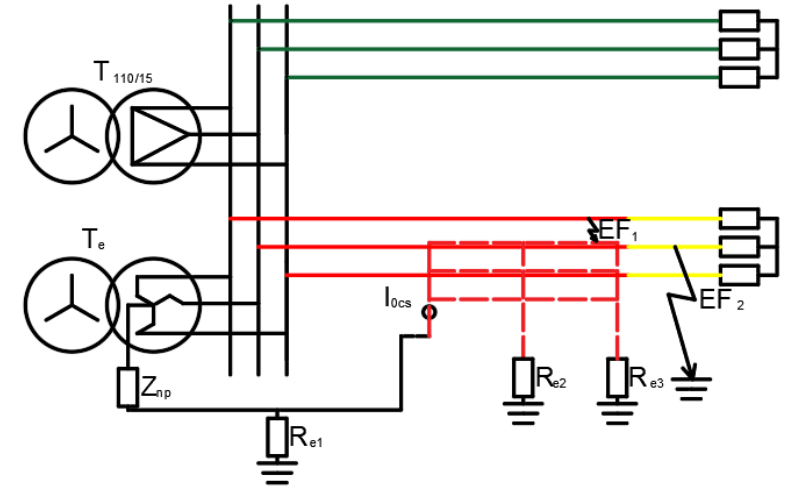
Figure 11. A model for testing the impact of the number and earthing systems of a cable line on the earth fault current distribution.